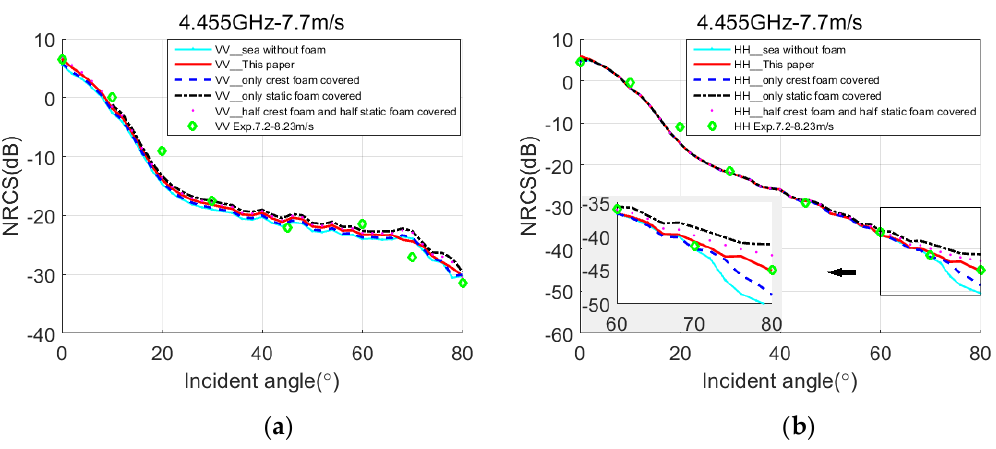
Figure 8. Comparison results of Normalized RCS (NRCS) by the proposed model, the sea surface covered with crest foam only, the sea surface covered with static foam only, the sea surface covered half crest foam and half static foam, and the measured data from JOSS-I model. f = 4.455 GHz, U 10 = 7.7 m/s. ( a ) VV polarization. ( b ) HH polarization.